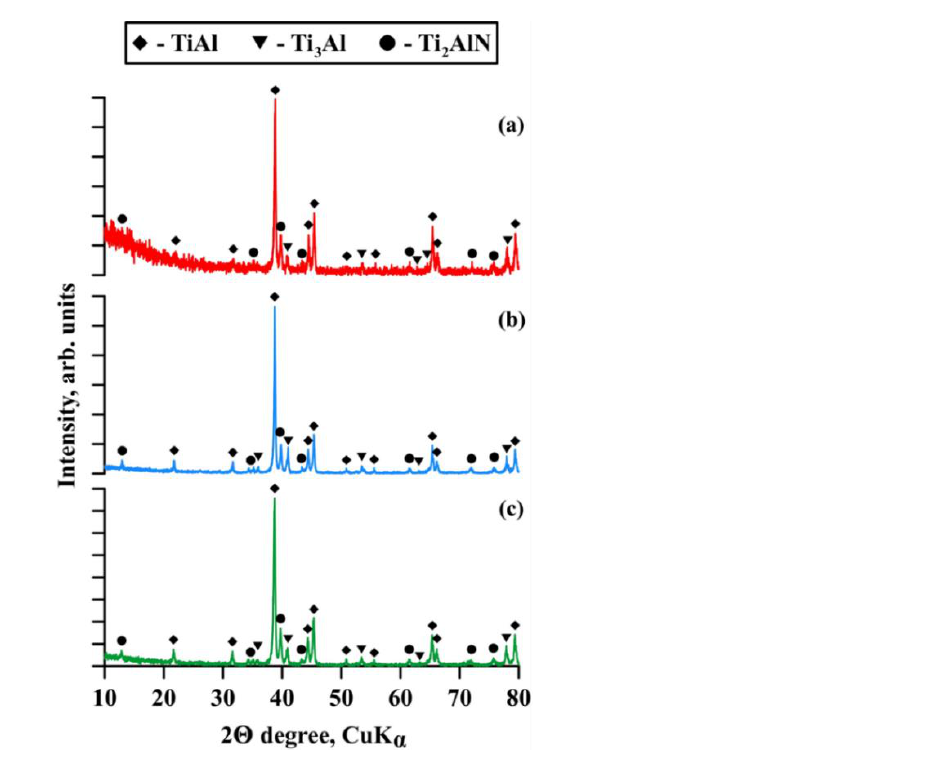
Figure 3. X-ray diagrams of the samples of additive-manufactured materials: sintering at 1100 °C ( a ); sintering at 1200 °C ( b ); sintering at 1250 °C ( c ). Table 1. Results of X-ray diffraction analysis of materials obtained by AM extrusion from a mixture of high-filled polymers (MEAM-HP) and Ti-Al intermetallide powders with subsequent sintering. Sintering Temperature, °C